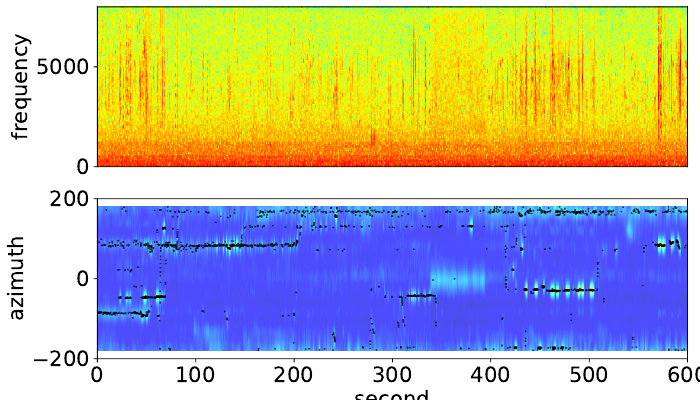
Figure 4. Visualization of localization based on microphone array 4. The top panel represents spectrograms obtained by STFT. The bottom panel shows the MUSIC spectrum (heat map) as well as the direction of arrivals (DOAs) distribution (black bars). We confirmed that these localized sounds included almost all vocalizations by the ZF individuals during the